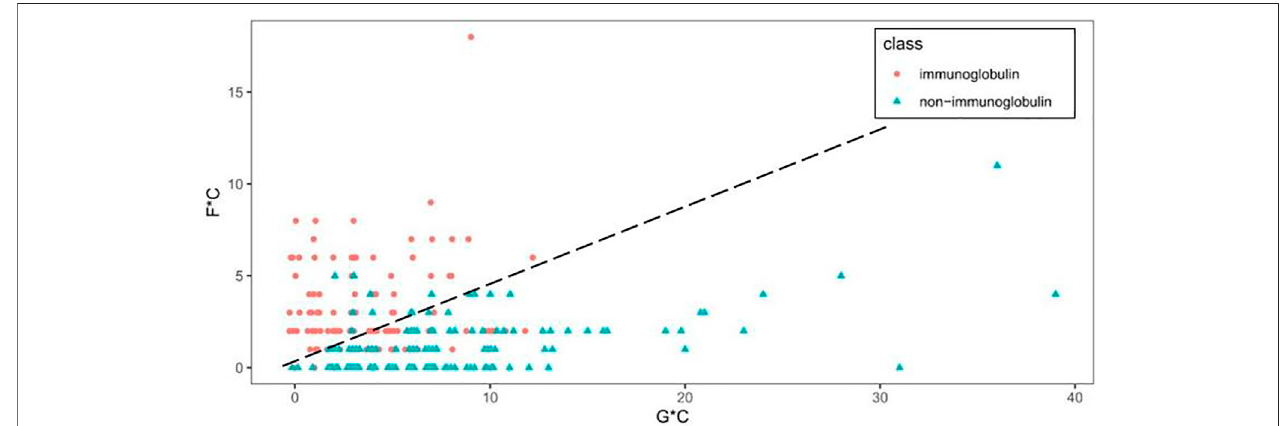
FIGURE 3 | Scatter plot of GC* and FC* features.